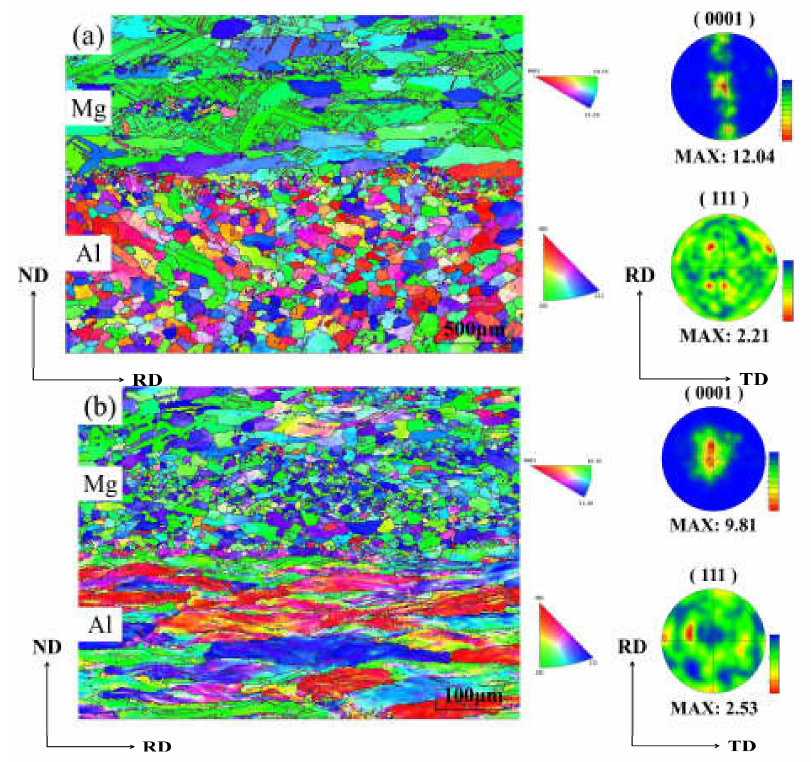
Figure 7. EBSD test results of Al and Mg composite plates: ( a ) not rolled, ( b ) fourth pass.